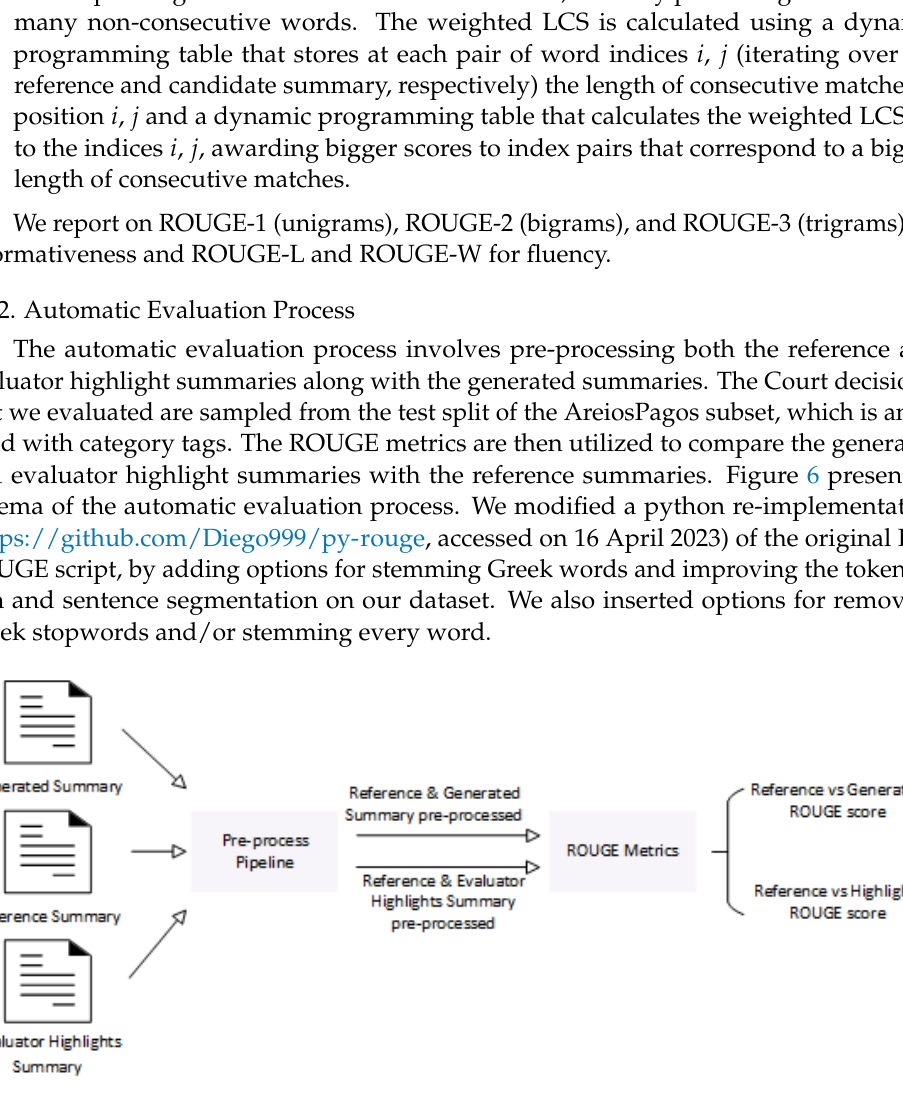
Figure 6. A schema of the automatic evaluation process. Both reference, evaluator highlight sum- maries and generated summaries are pre-processed. The ROUGE metrics are used to compare generated and evaluator highlight summaries versus the reference